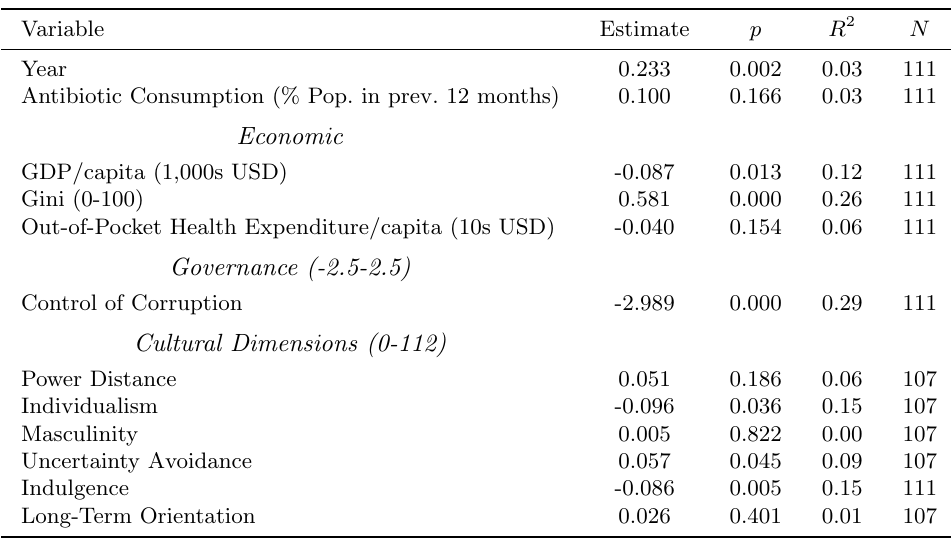
Table 2: Results of bivariate cluster-robust linear regressions of national characteristics and the percentage of antibiotic self-medication among antibiotic consumers Variable Estimate Antibiotic Consumption (% Pop. in prev. 12